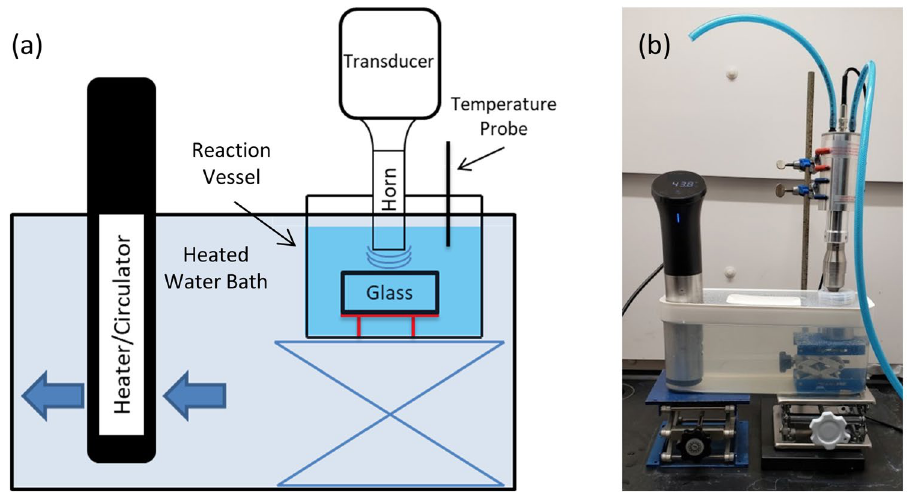
Figure 1. Schematic created using PowerPoint ( a ) and apparatus ( b ) used for ultrasonic dissolution experiments. Experiments took place in a stainless steel reaction vessel which had the reaction temperature was regulated by a surrounding water